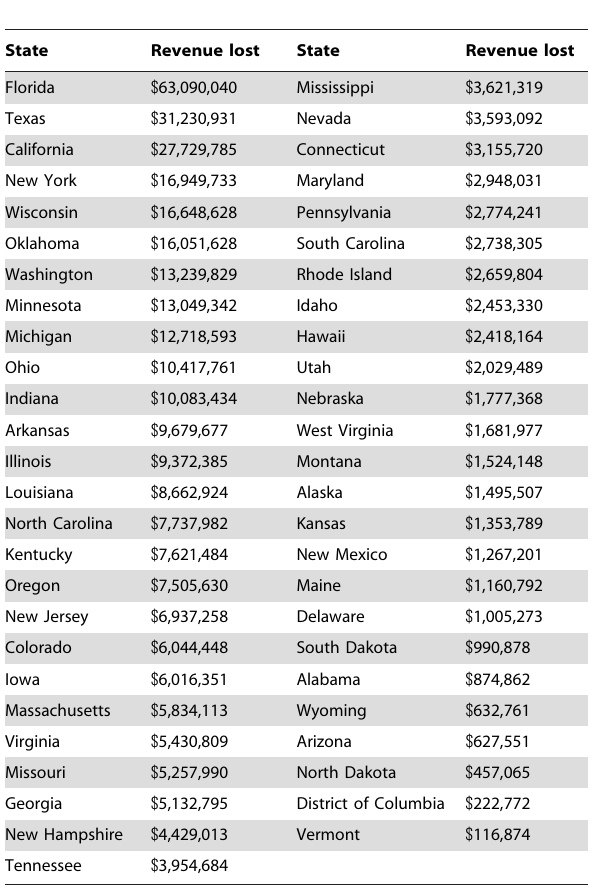
Table 2. $ 374 million in state revenue losses from RYO